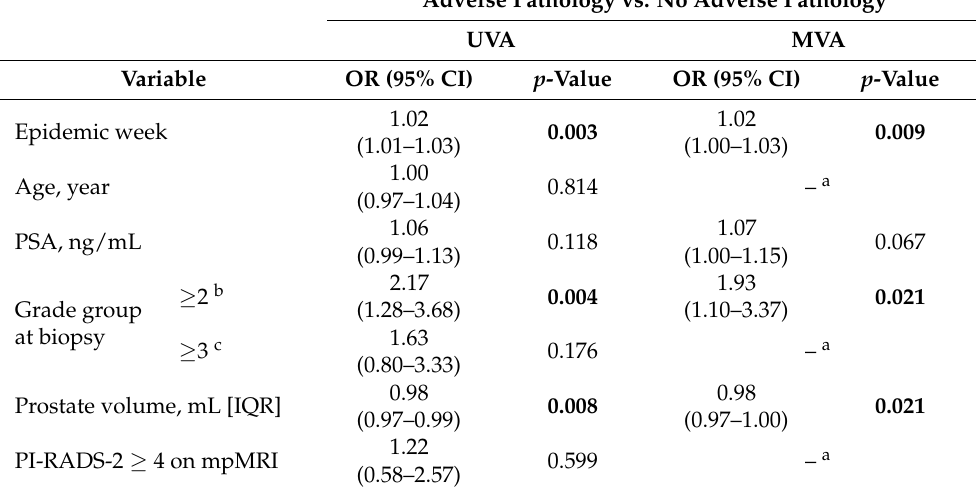
Table 3. Associations between the date of surgery (epidemic week), patient- and disease-related variables, and the risk of adverse pathology within the cohort of non-high-risk